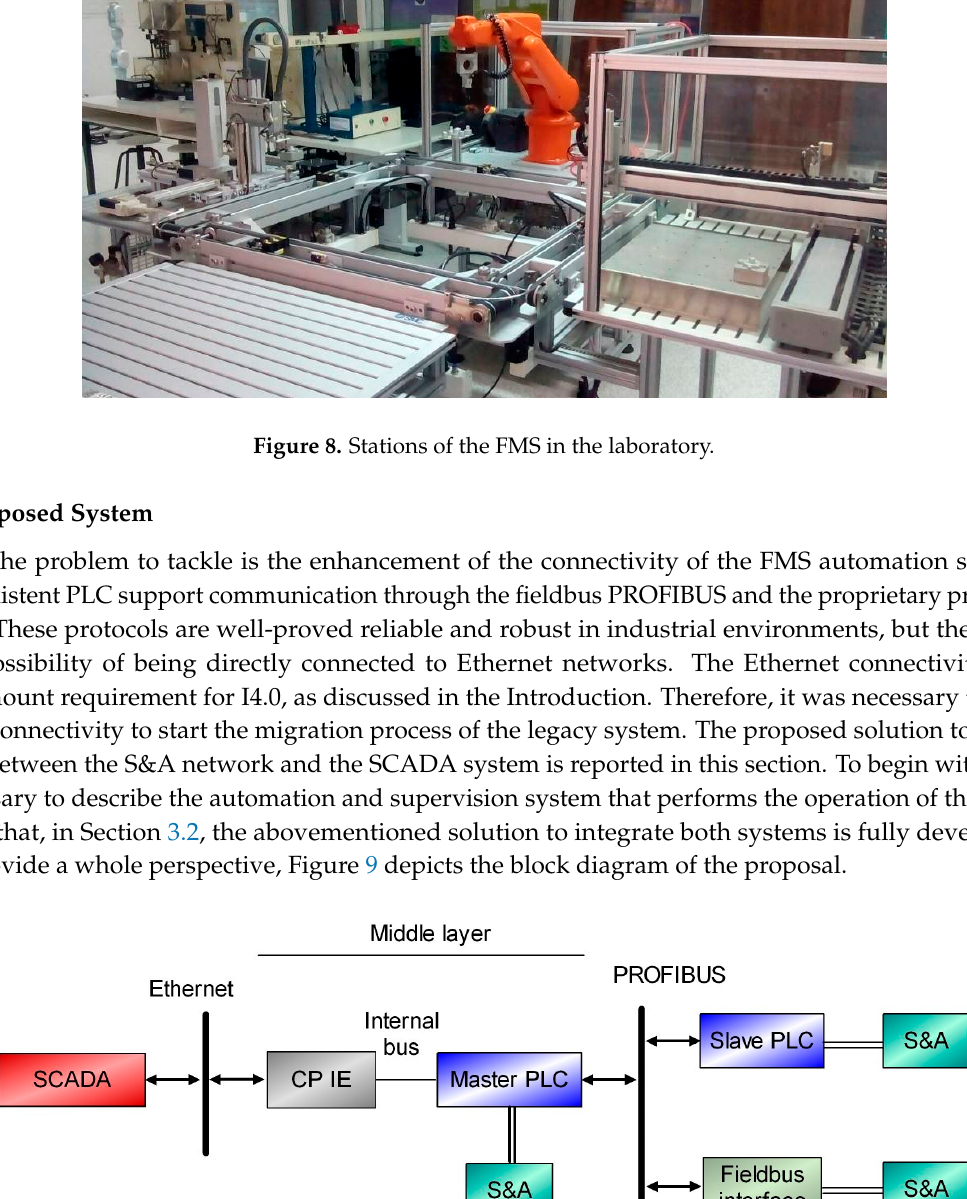
Figure 7. Block diagram of the layout of the stations.